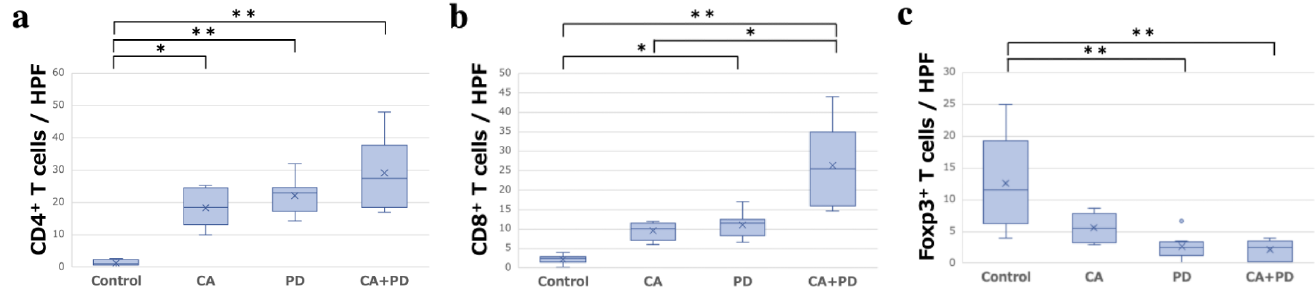
Figure 4. Representative findings of H-E staining and immunostaining. ( a ) H-E staining of a sagittal slice of the right lower limb. AT in the tibia is extending extraosseous (F: femur, T: tibia, *: AT). ( b ) HPF of the AT tissue with H-E staining. ( c ) HPF of AT tissue of the No. 3 sample in the CA group with CD8 immunostaining. Brown-stained cells are positive. HPF, high-power field; AT, abscopal tumor.